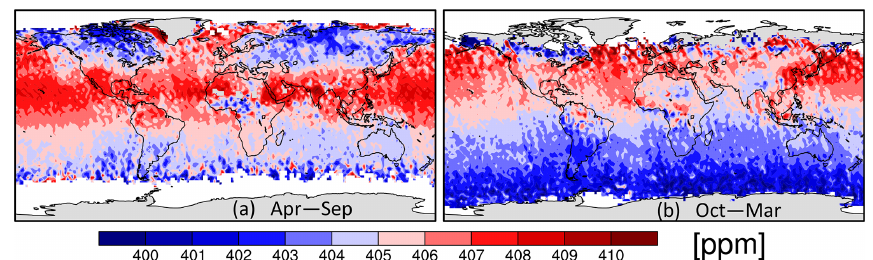
Figure 5. The 10s average X CO value for September 2014–October 2020 binned into 2 ◦ × 2 ◦ boxes and for (a) April–September and (b) 2 October–March given by the two-step averaging approach (an information-weighted average of five 2s